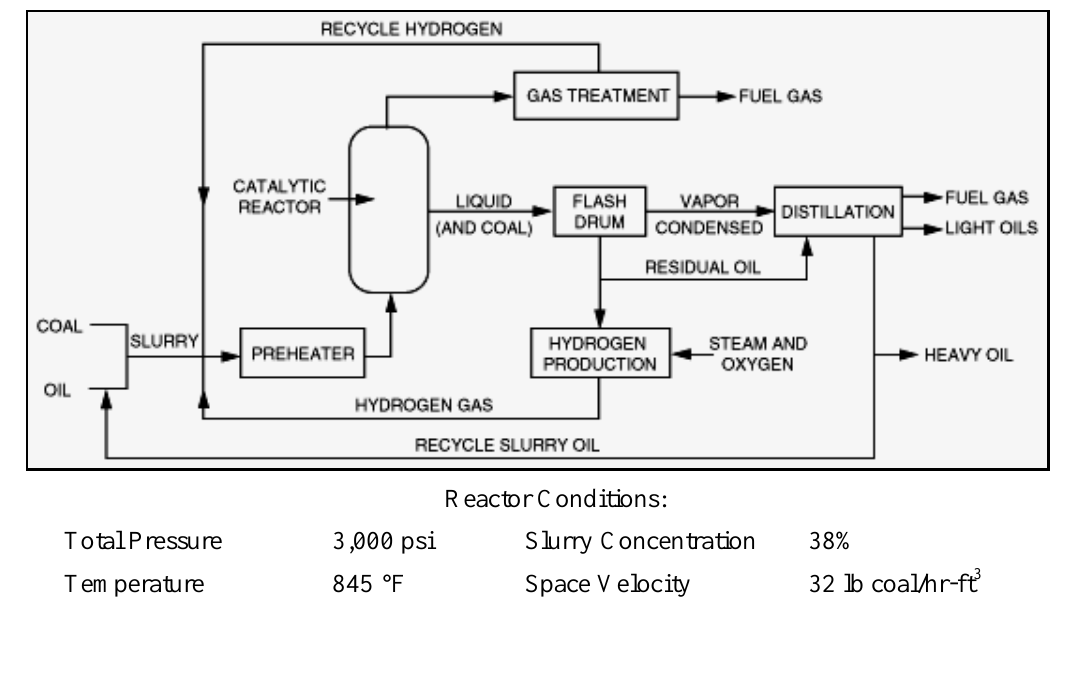
Figure 4. H-Coal